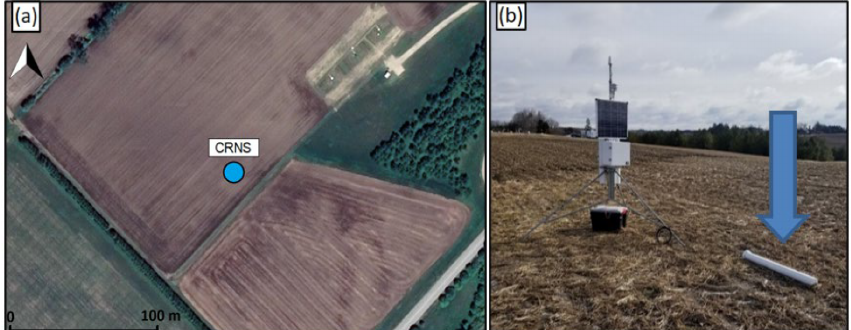
Figure 2. (a) Location of CRNS at the Elora site during the 2016/2017 and 2017/2018 seasons (© Google Earth Pro 2020). (b) The location of the sensor tube is indicated by the blue arrow.